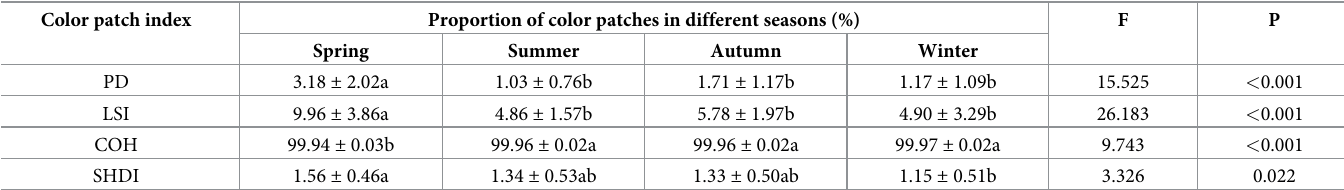
Table 3. Difference analysis of forest color patches in different seasons.